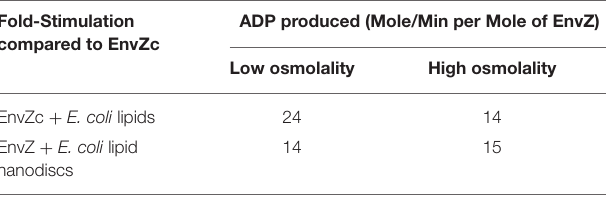
TABLE 1 | Lipid interactions enhance EnvZ autophosphorylation [adapted from Ghosh et al. (2017)]. Fold-Stimulation ADP produced (Mole/Min per Mole of EnvZ) compared to EnvZc Low osmolality High osmolality EnvZc + E. coli lipids 24